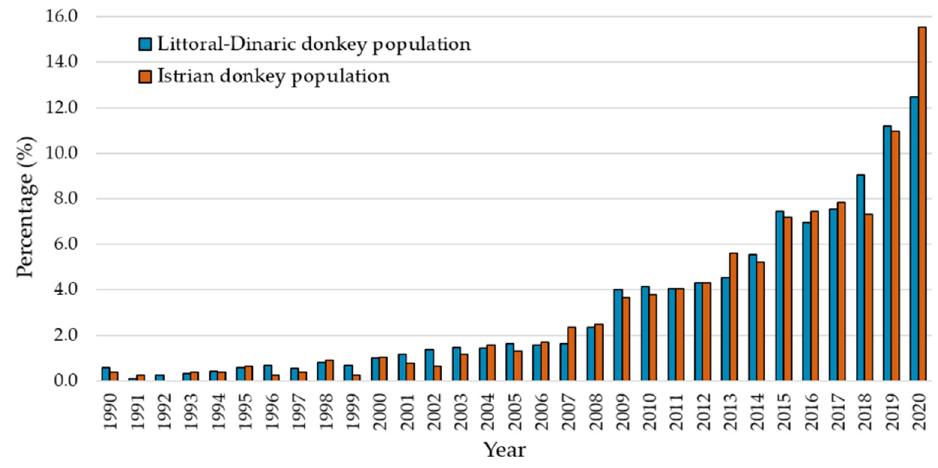
Figure 2. Share of animals in the Littoral-Dinaric donkey and Istrian donkey populations by year of foaling. Table 1. Summary statistics of the pedigree analysis of the Littoral-Dinaric donkey (LDD) and Istrian donkey (ID)